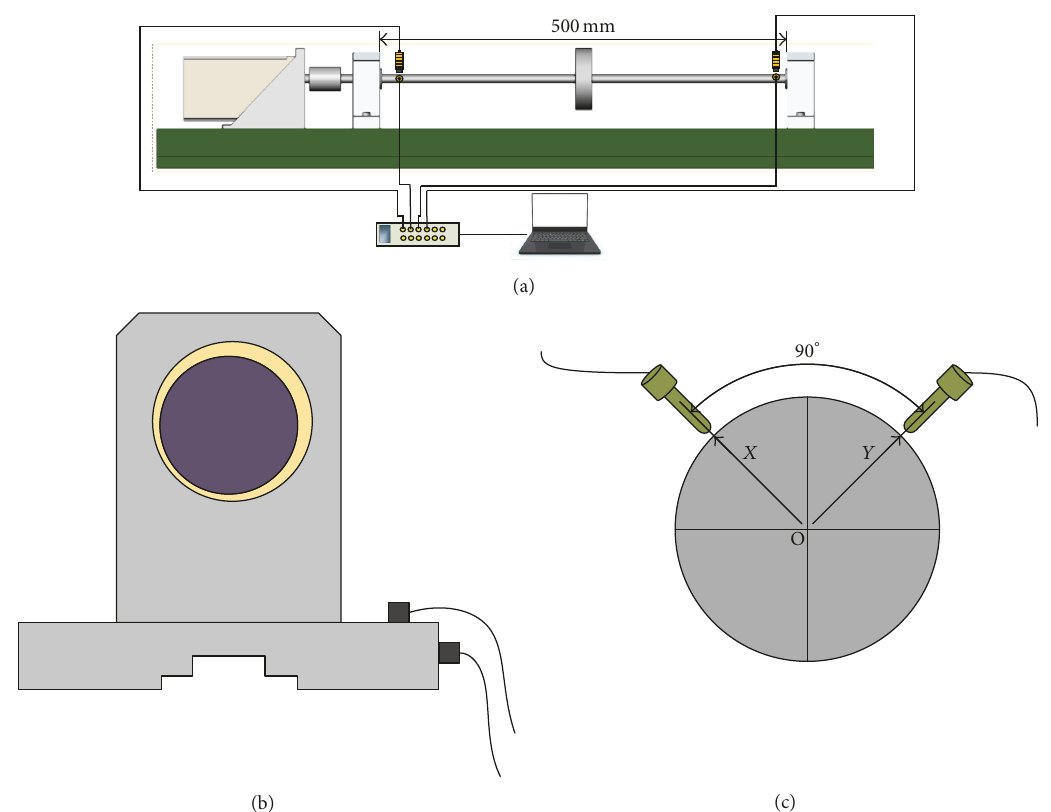
Figure 1: Schematic view of the test rig: (a) general view; (b) accelerometers installation; (c) eddy current sensors installation.